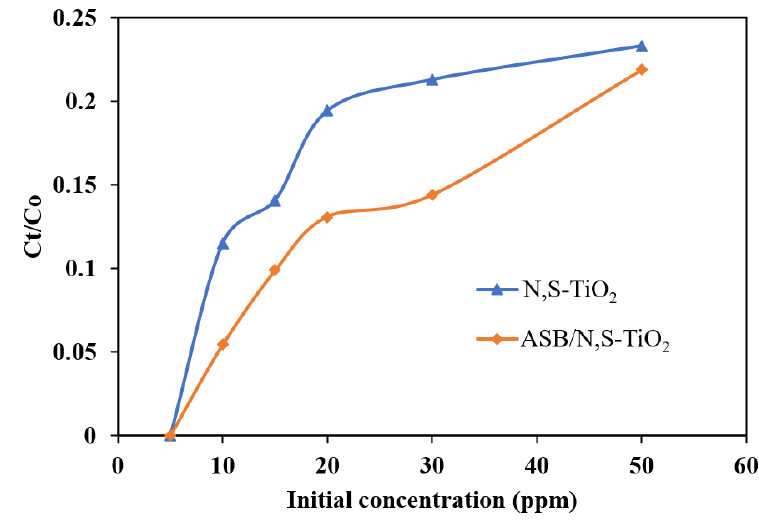
Figure 8. Effect of initial concentration on removal for N,S-TiO 2 and ASB/N,S-TiO 2 composites (condition: contact time = 150 min irradiation, pH = 5.5–6, dosage = 0.05 mg).